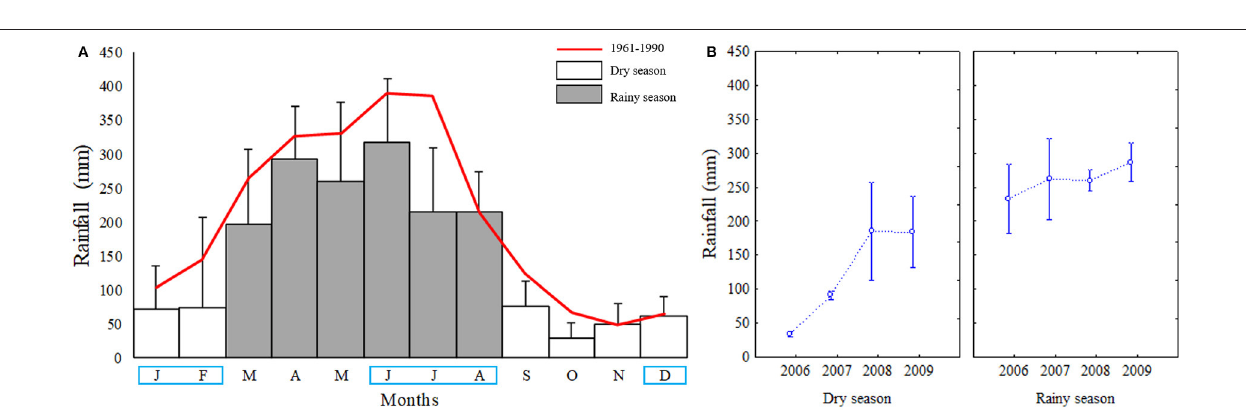
FIGURE 2 | (A) Most recent climatic rainfall average 1961–1990 (red line) and at Goiana River estuary in periods 2006–2009 (bars) (highlighted months in blue) were those used in this study; (B) Average seasonal rainfall of years studied